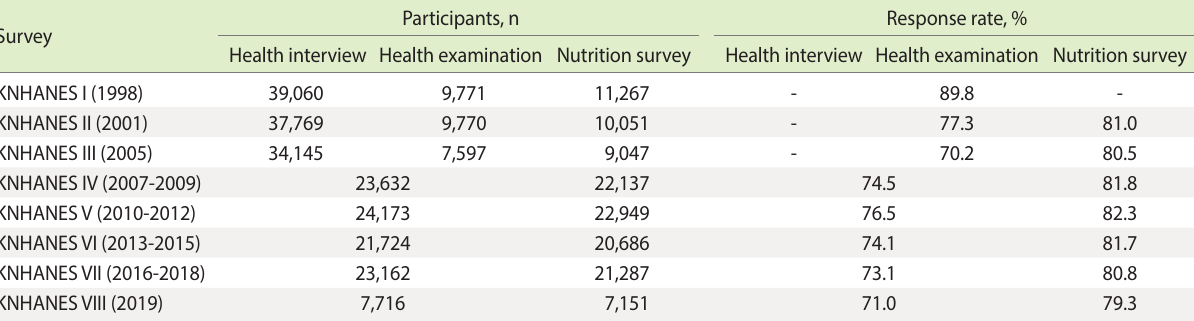
Table 2. Data collection for the Korea National Health and Nutrition Examination Survey (KNHANES)